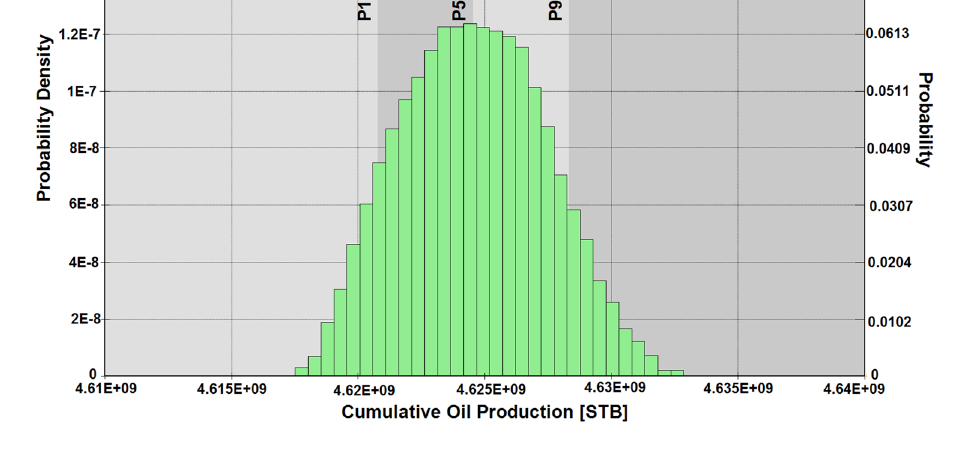
Fig. 18 Cumulative probability distribution of reservoir flow response under production